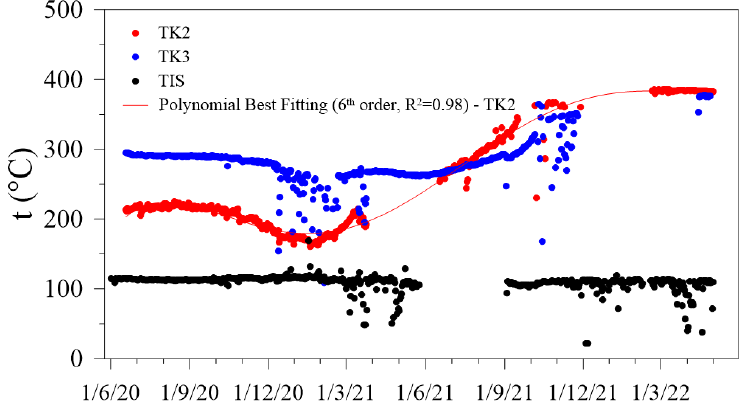
Figure 7. Outlet temperatures of some selected HTF.